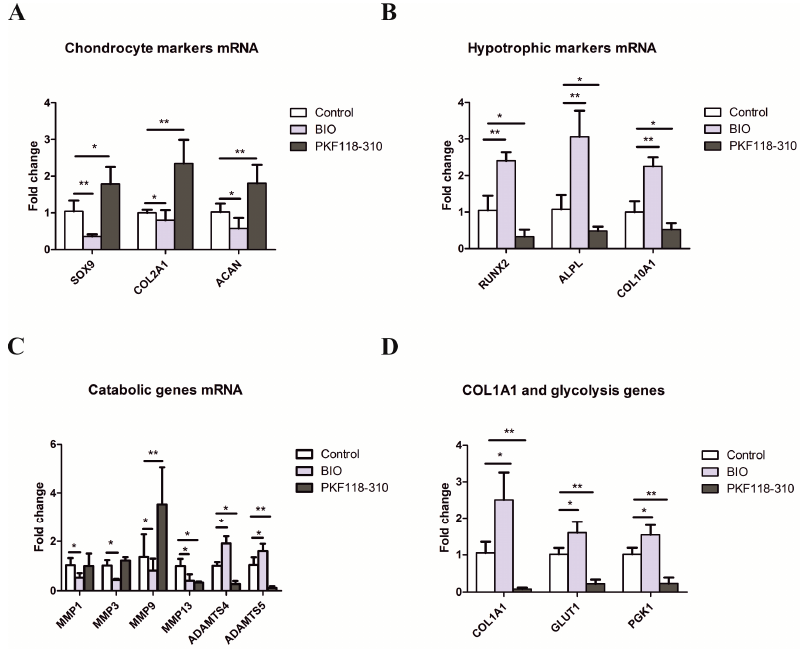
Figure 2. Gene expression in hMSCs pellets after activating/inhibiting canonical WNT signaling. The expression of ( A ) chondrocyte markers; ( B ) hypertrophic markers; ( C ) catabolic genes; and ( D ) COL1A1 and glycolysis genes. hMSCs pellets were cultured in chondrogenic differentiation medium with supplementation of 2 µM BIO or 3 µM PKF for 5 weeks. After 5 weeks, RNA samples were extracted from pellets and the expression of specific genes was analyzed by qPCR. Relative expression levels of different genes were normalized using RPL13A. Data are presented as an average of three hMSCs donors ± SD. * p < 0.05, ** p < 0.01. The error bar represents the Standard Deviation (SD).